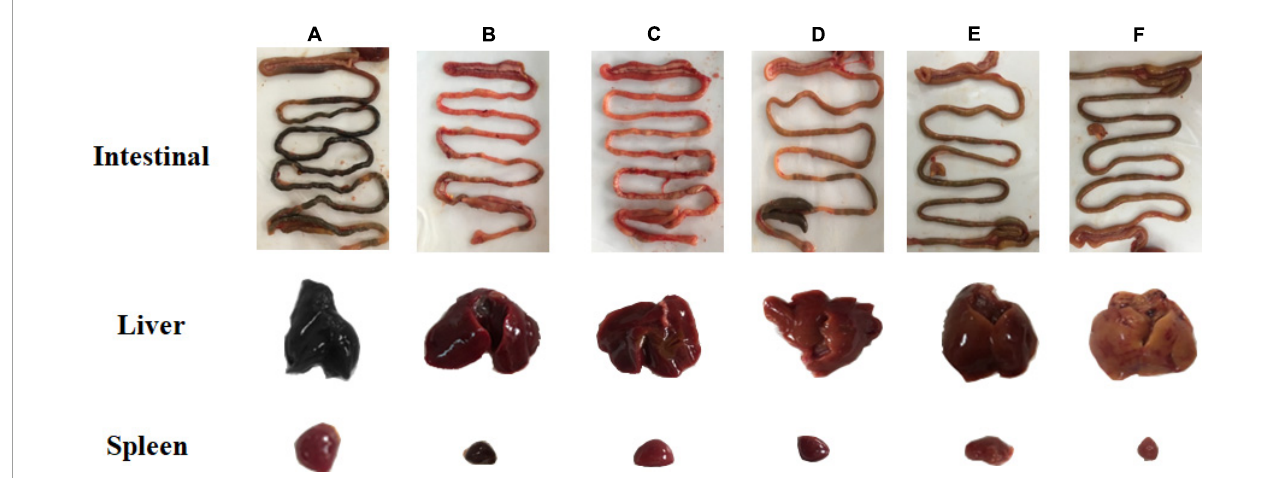
FIGURE5 Pathological changes of intestinal, liver, and spleen and in chickens with different treatments. For the prophylaxis group, HJH-3 or Ampicillin was used by injected intraperitoneally (IP) (200 µ g/mL, 0.5 mL), and then the chickens were infected with S. Pullorum. For the treatment group, the chickens were infected with S. Pullorum, and then HJH-3 or Amp was used by IP (200 µ g/mL, 0.5 mL). (A) Infection group (G-INF); (B) antimicrobial peptide treatment group (G-HJH-C); (C) antibiotic treatment group (G-Amp-C); (D) antimicrobial peptide prevention group (G-HJH-P); (E) antibiotic prevention group (G-Amp-P group); (F) control group (G-CON).